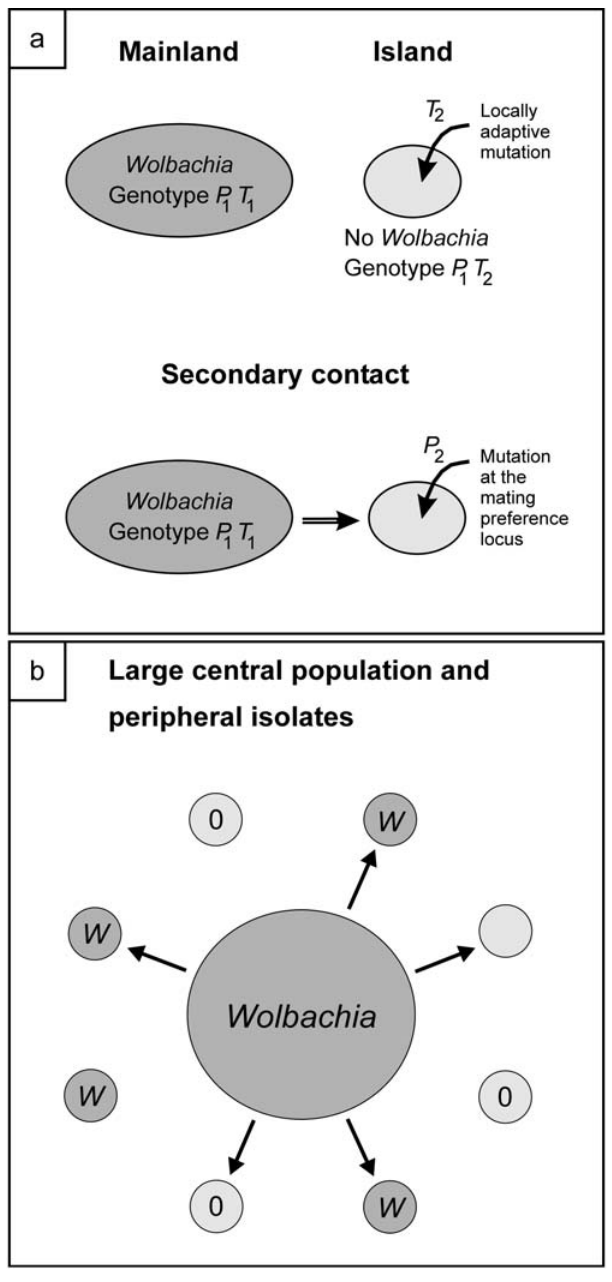
Figure 1. Model scenario. Graph (a): The ancestral situation is a large mainland population infected with Wolbachia and a small peripheral island population without Wolbachia . Further, the populations have diverged at a phenotypic trait locus T , with local adaptation in the island population of the T 2 allele. After migration from mainland to island is restored (secondary contact), a new allele at the mating preference locus, P 2 , is introduced at low frequency in the island population. Females with P 2 prefer T 2 males relative to T 1 males. We investigated the stability of infection differences between the populations, probability of local adaptation at the selected locus in the presence of migration, under what conditions mutants at the mate preference locus can invade and result in genetic divergence and prezygotic isolation. Graph (b): The mainland-island model analyzed in this article applies to a situation with a large central population and small peripheral isolates. The peripheral isolates might face migration from the infected mainland or not. Some of the isolates are infected with Wolbachia while others have lost the infection. Our results suggest that it is the ones that lose their Wolbachia that are more likely to diverge into new species. doi:10.1371/journal.pone.0000701.g001 PLoS ONE |